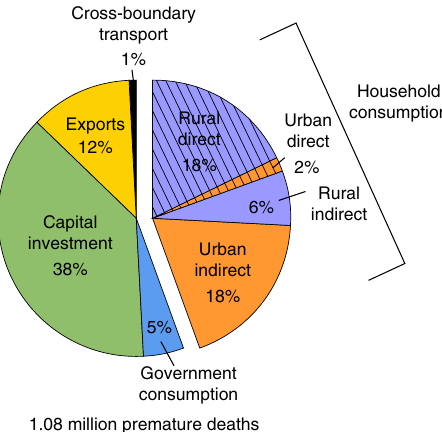
Fig. 1 Outdoor PM 2.5 -related premature deaths attributed to sources and consumption activities in 2012 in China. Total number of PM 2.5 -related premature deaths attributed to anthropogenic emissions, and their attribution to fi nal demand categories from supply chain